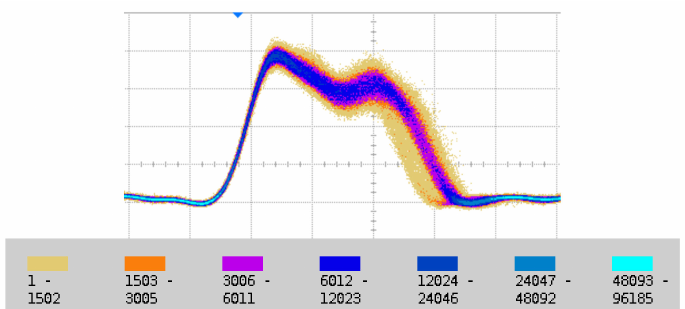
Figure 12. Long term (12 h) pulse stability measurement. Infinite trace persistence with temperature grading was used. Horizontal axis 250 ps/div; vertical axis 250 mW/div. The legend describes the number of hits in the trace